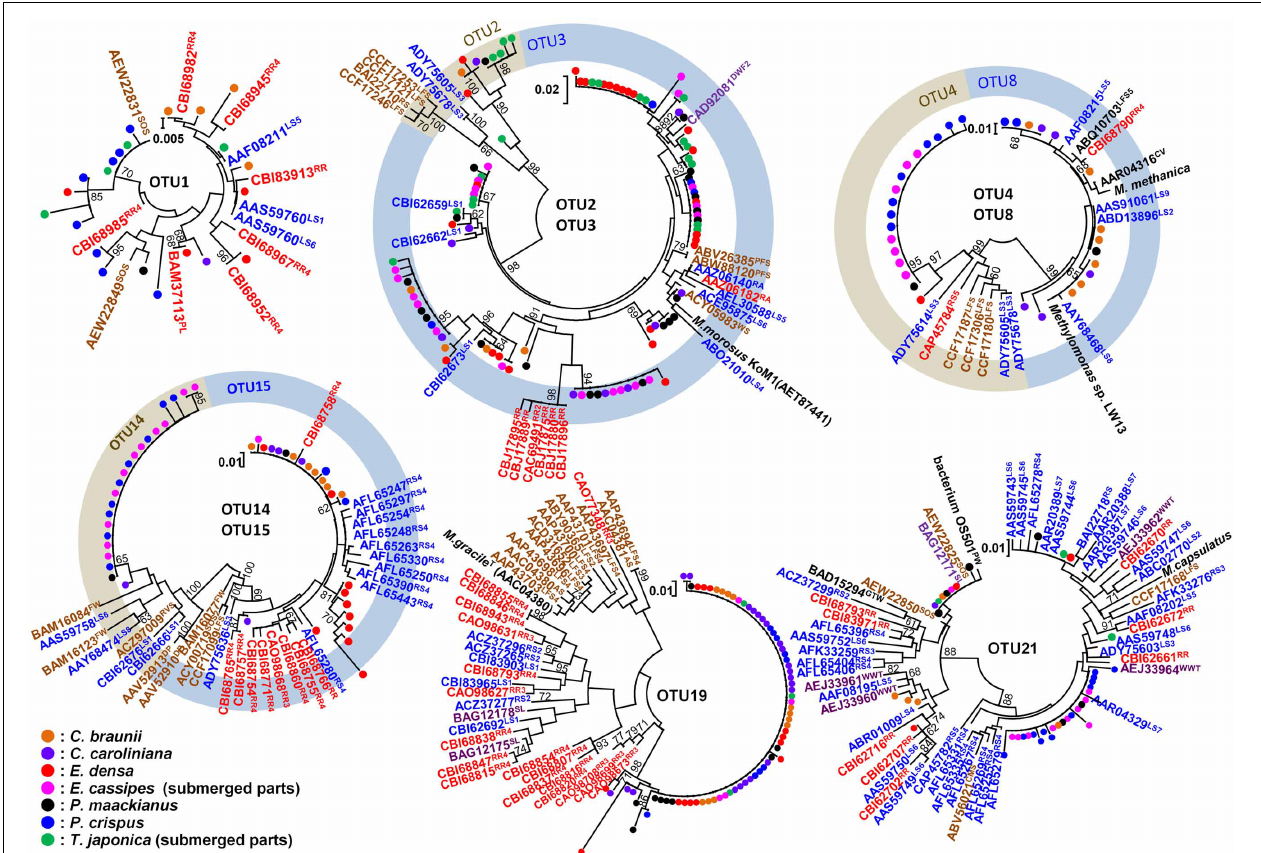
FIGURE 5 | Neighbor-joining tree of individual clones in abundant OTUs and their related environmental clones based on deduced amino acid sequences of pmoA genes. The clones obtained in this study were indicated as closed circles. Bootstrap values ( > 60%) obtained from 1000 resamplings are shown. Related clones are indicated as accession numbers with superscript indicating their origins as follows; plants in red including RR, rice root and PL, plant leaf, saturated soil or sediment in blue including RS, rice field soil; LS, lake sediment; RA, river aquifer; TCE, TCE-contaminated